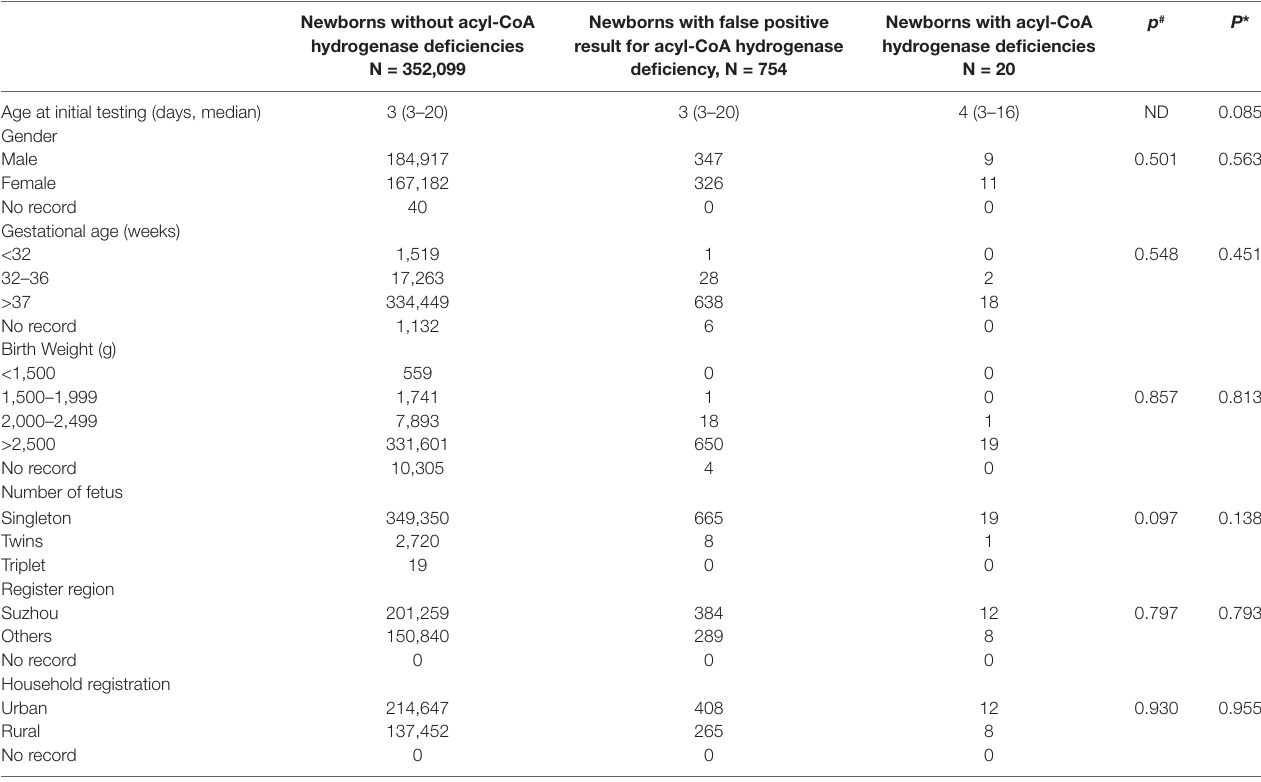
# Comparison between group of newborns with acyl-CoA hydrogenase deficiencies and group of newborns without acyl-CoA hydrogenase deficiencies. *Comparison between group of newborns with acyl-CoA hydrogenase deficiencies and group of newborns with false positive result for acyl-CoA hydrogenase deficiency. ND, not